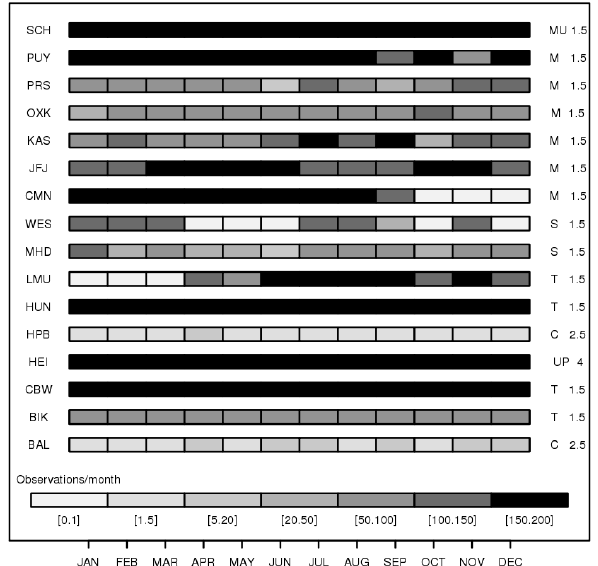
Figure 2. Monthly data coverage plot for the atmospheric stations used in the regional inversions. The left column shows the code name and the right columns show the station class and the assigned uncertainty in units of ppm. “C” stands for continental sites near the surface, “T” for continental tall towers, “S” for stations near shore, “M” for mountain sites, “MU” for mountain sites with diurnal ups- lope winds and “UP” for urban